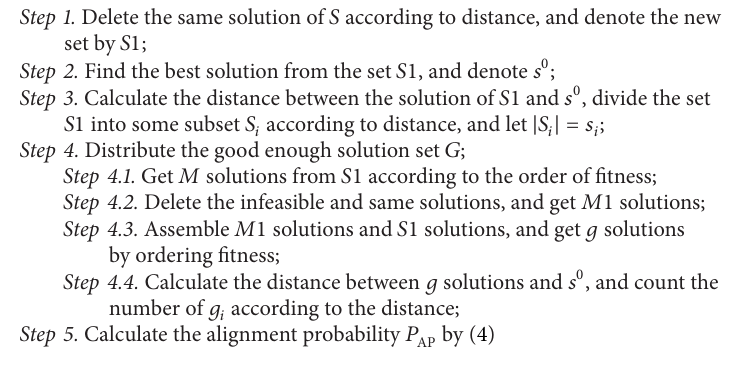
Algorithm 1: The main steps of assessment